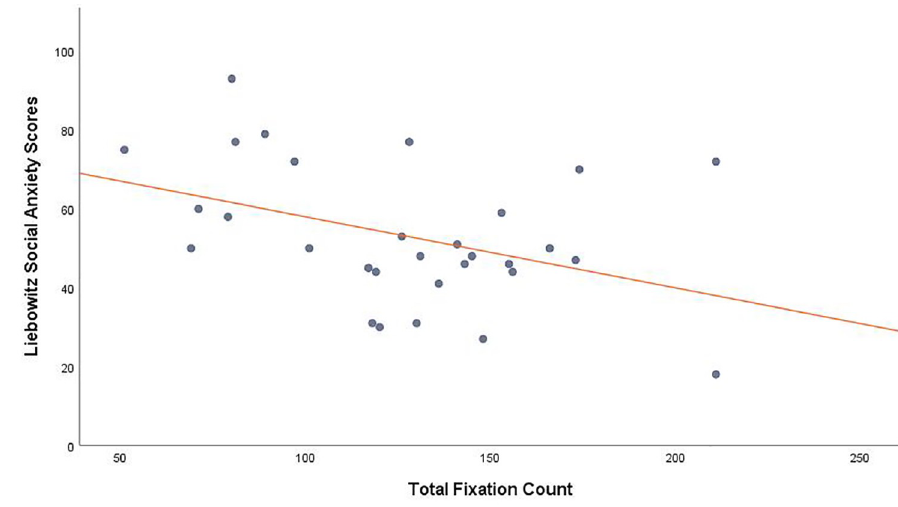
Fig 4. Scatterplot showing a negative correlation between total fixation count and SA traits.